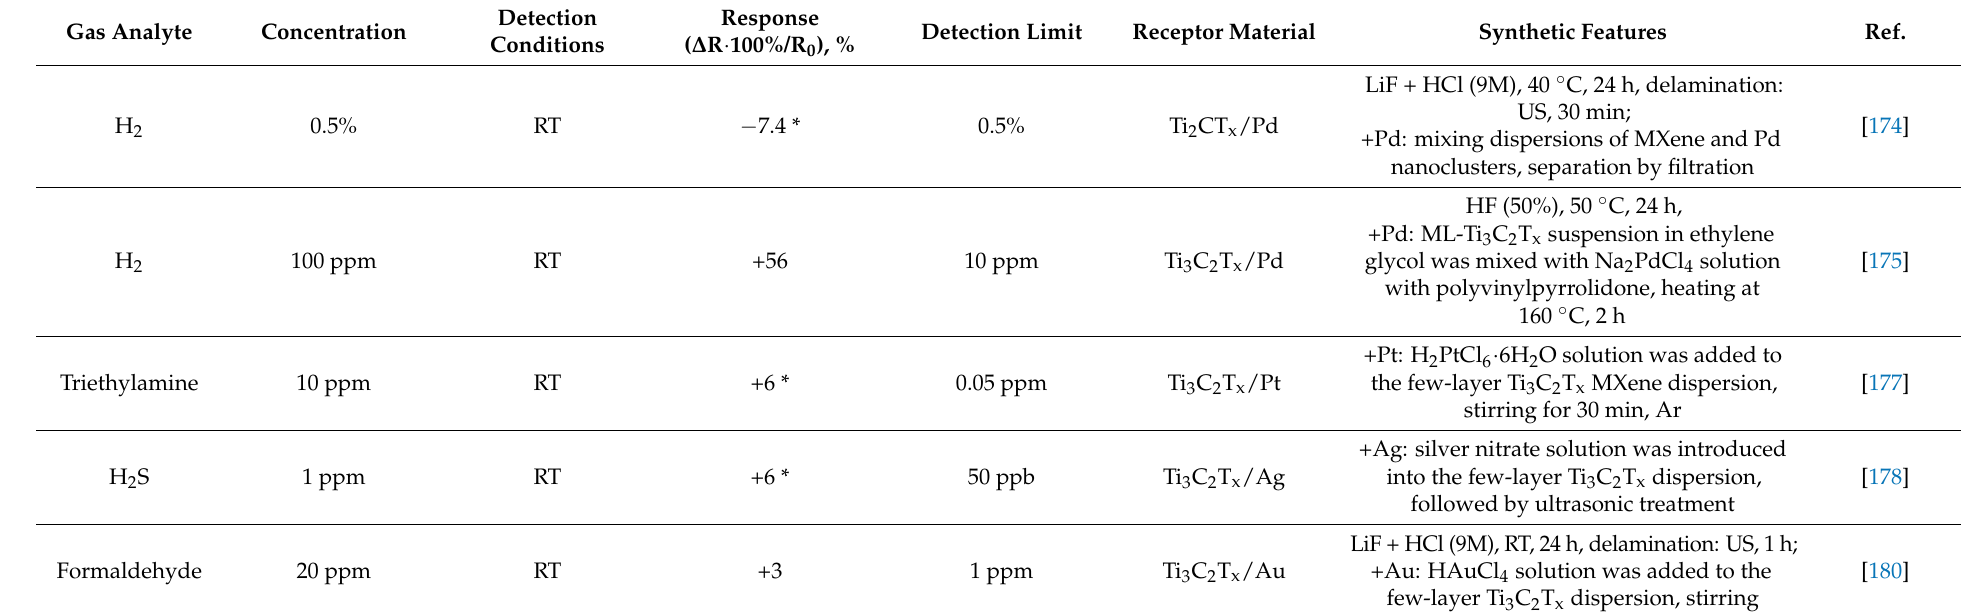
Table 5. Sensory characteristics of coatings based on nanocomposites containing Ti 3 C 2 T x /Ti 2 CT x MXenes and noble metal